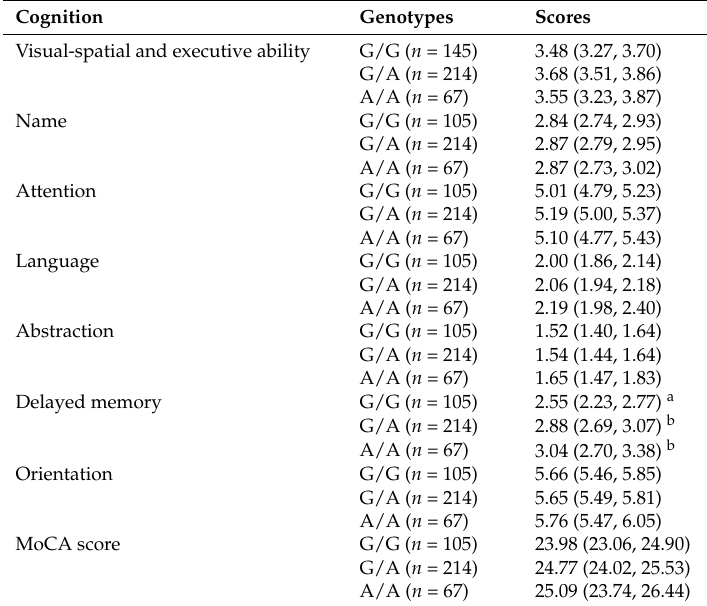
Table 8. MoCA scores by SLC19A1 G80A